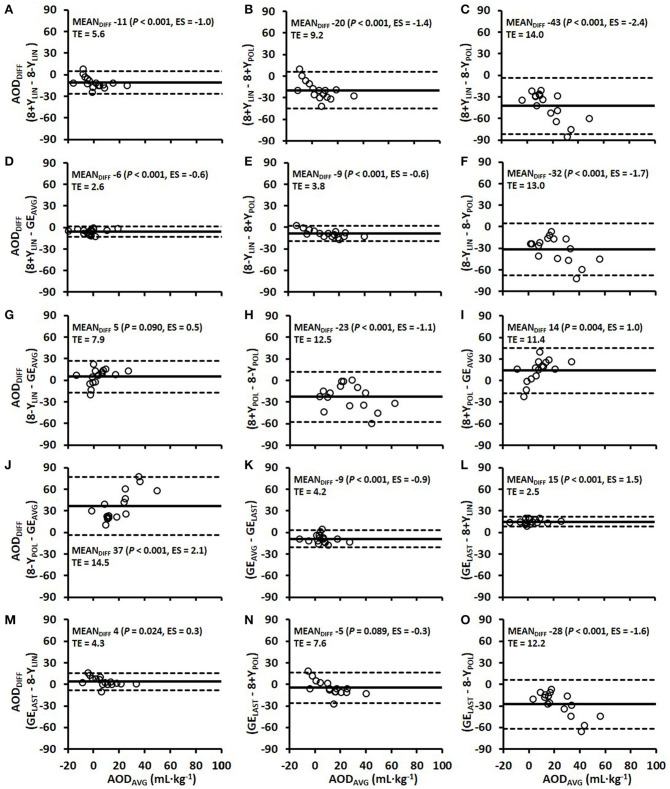
Bland-Altman plots for the six various models of estimating the accumulated oxygen deficit (AOD) associated with the 4-min time trial using the double poling sub-technique (A–O). Bland-Altman plots represent the mean difference (MEANDIFF) in the AOD ± 95% (1.96 SD) limits of agreement between the methods. Abbreviations: AODDIFF, the difference in AOD; TE, typical error; ES, Hedges's gav effect size, 8+YLIN and 8-YLIN, the 8 × 4-min linear maximal accumulated O2 deficit methods with the baseline V.O2 as a Y-intercept either included (8+Y) or excluded (8-Y); 8+YPOL and 8-YPOL, the 8 × 4-min polynomial (second degree) maximal accumulated O2 deficit methods with the baseline V.O2 as a Y-intercept either included (8+Y) or excluded (8-Y); GEAVG, the gross efficiency method based on the average of eight submaximal stages; GELAST, the gross efficiency method based on the last submaximal stage.